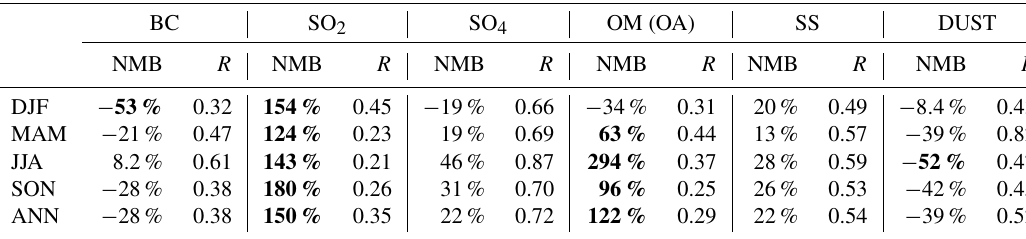
Table 5. Seasonal and annual normalized mean biases (NMBs) and Pearson correlation coefficients ( R ) for NUDGE_PD vs. observed climatological surface concentrations (see http://aerocom.met.no, last access: 24 September 2018; cf. Fig. 6). NMBs with absolute values of 50% or more are listed in bold